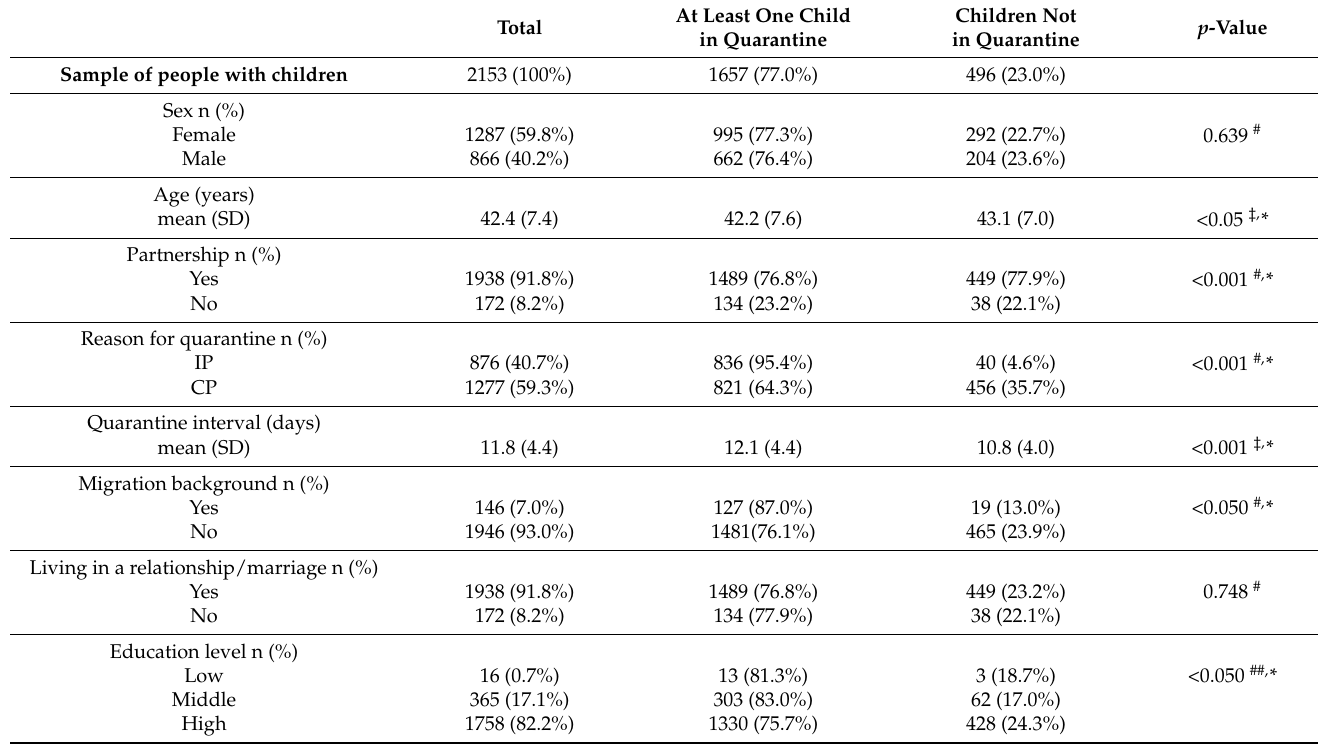
Table 2. Study population and demographic